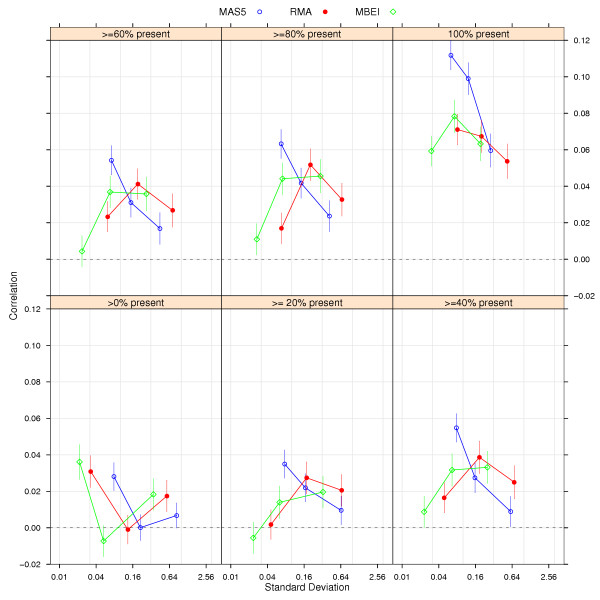
Correlations of pairs of genes sampled from subsets with an increasing minimum percentage of present calls for probe sets. From the breast cancer data, 5000 pairs of genes were randomly sampled from the subset of probe sets that were present on at least one of the chips, the subset of probe sets that were present on at least 20% of the chips etc., finally from the subset of probe sets present on all chips. The three curves represent the three expression measures. Excluding the probe sets that are always absent already reduces the residual correlation considerably, excluding the probe sets that are more than 80% absent breaks the pattern of highest correlation at smallest variability for RMA and MBEI seen in Figures 2, 3, 6, and 7. Using only probe sets that are always present however leads to a notable increase in residual correlation, especially for MAS5.